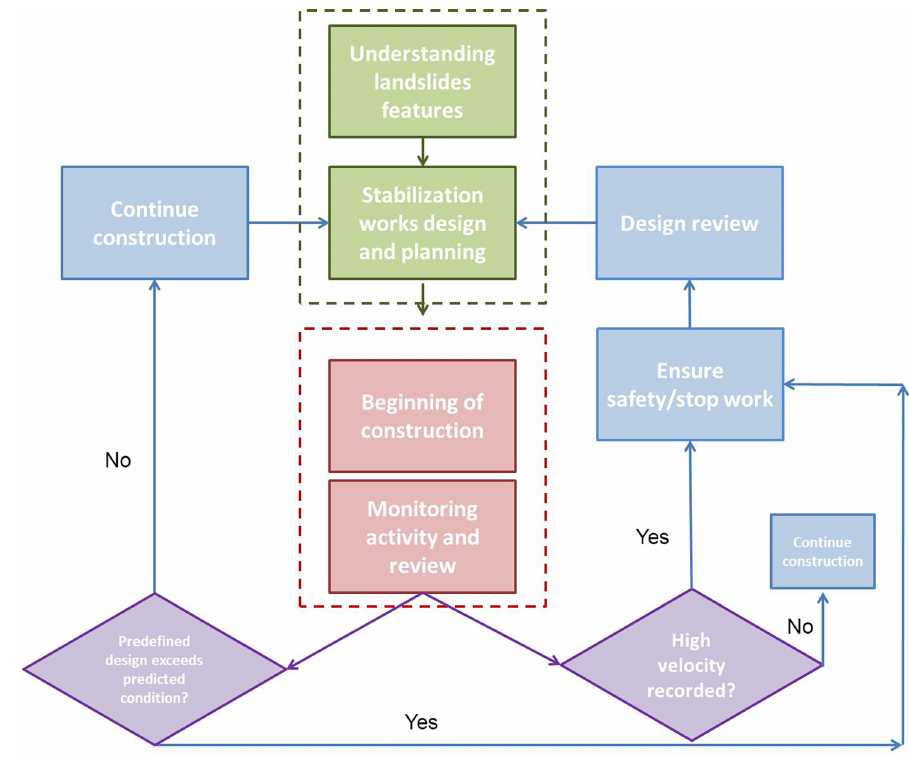
Figure 4. Conceptual flowchart of the application of the OM to the Montaguto remediation